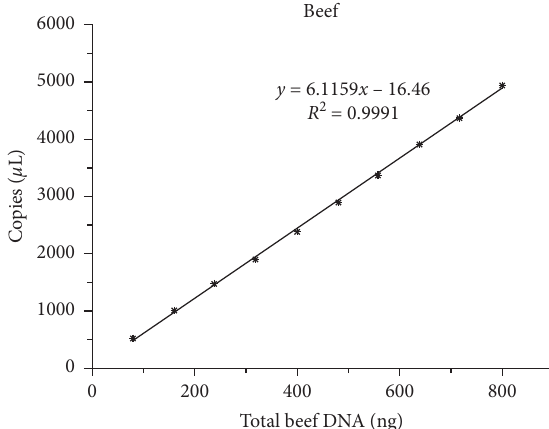
Figure 1: The specificity detections of the beef and duck primer-probe system.